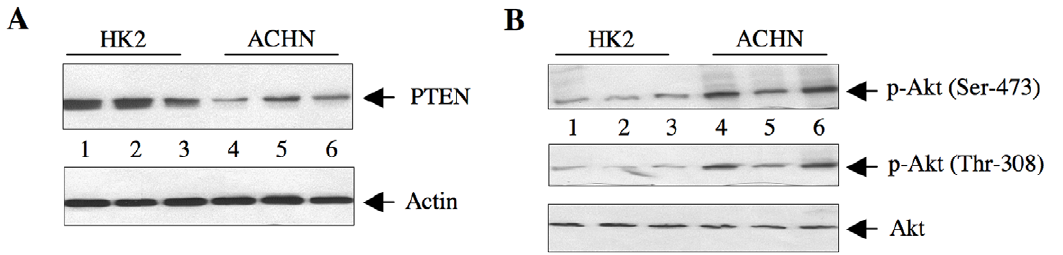
Figure 3. Expression of PTEN in HK2 and ACHN cells. (A) The lysates of cells from three independent wells of HK2 and ACHN cells were immunoblotted with PTEN and actin antibodies. (B) The same cell lysates were immunoblotted with phospho-Akt (Thr-308), phospho-Akt (Ser-473) and Akt antibodies.